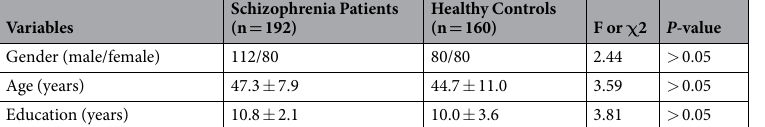
Table 1. Demographic characteristics in schizophrenia patients and healthy controls Mean ± SD (standard deviation).